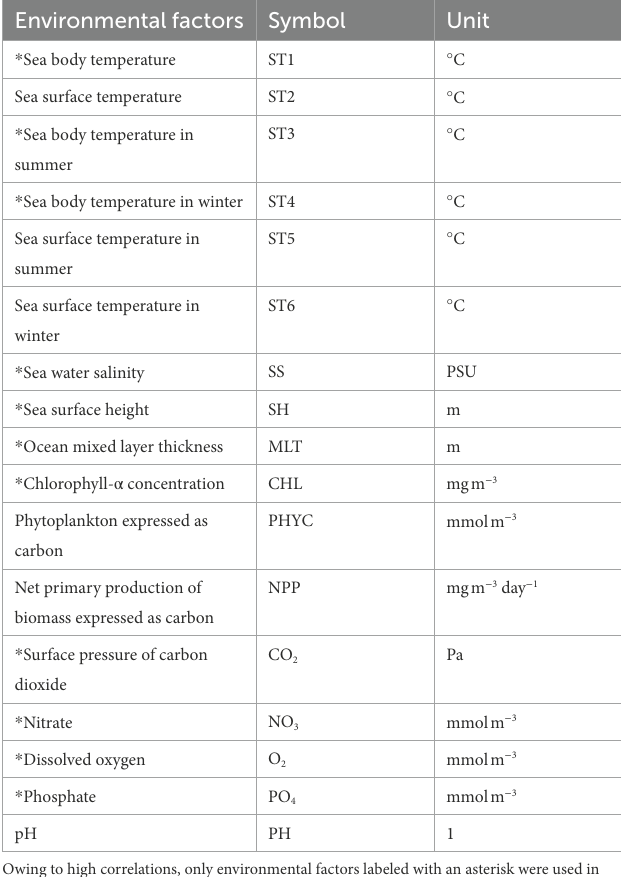
TABLE 1 Environmental factors used in this study and their units. Environmental factors